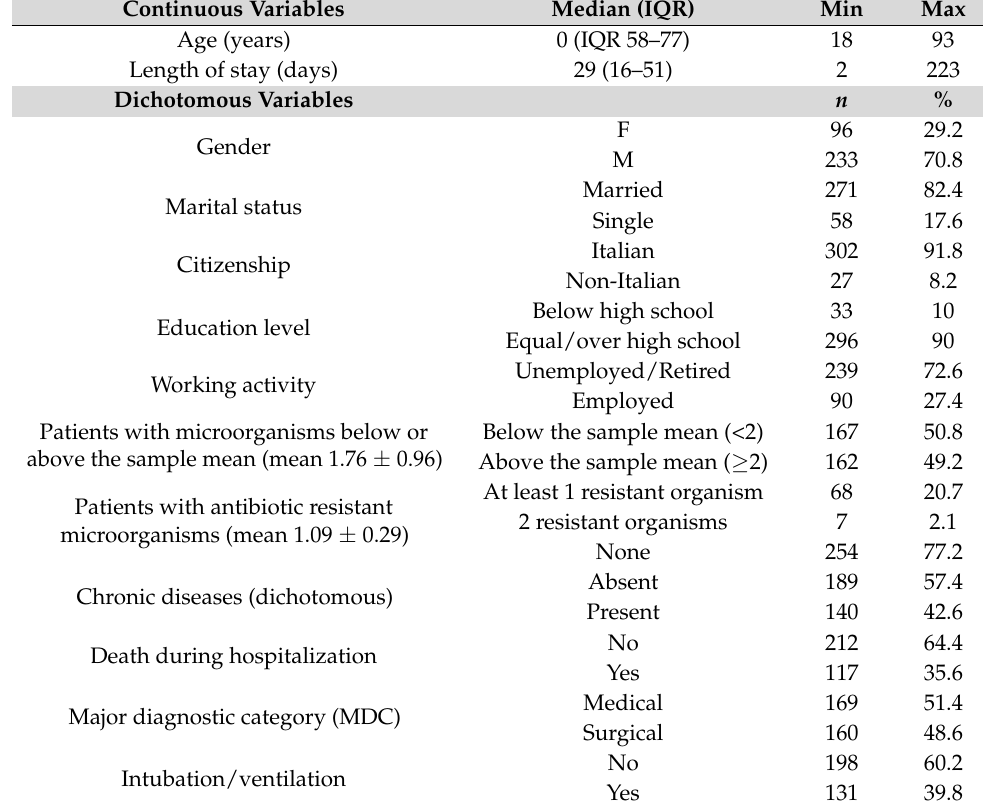
Table 1. Demographic and clinical characteristics of patients with HARI over a 12-month